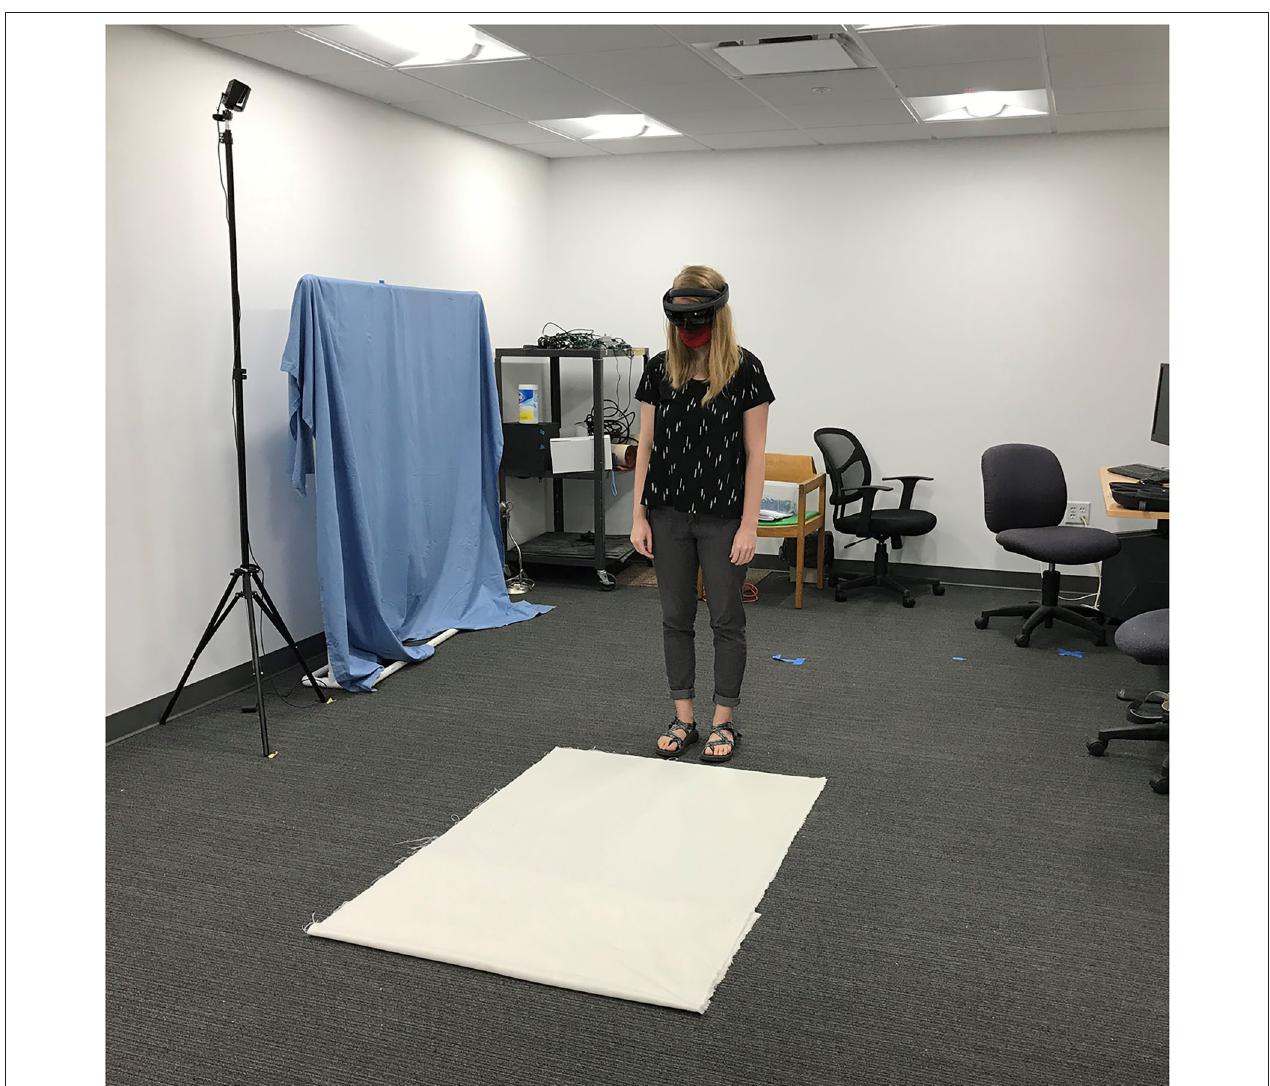
FIGURE 1 | Participant making a gap affordance judgment in the Experiment 2 real-world condition. The HoloLens was not worn in the Experiment 1 real-world